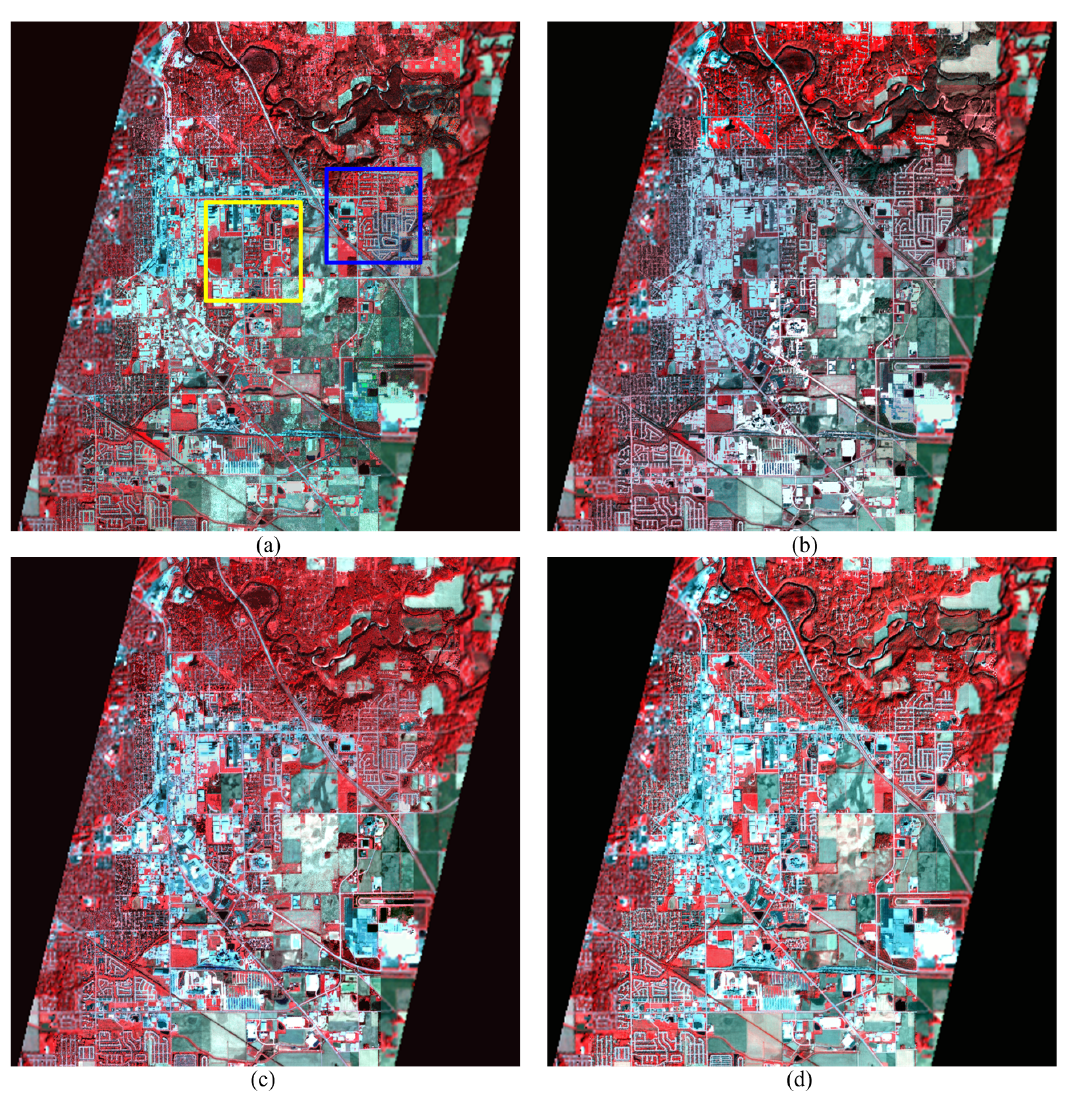
Figure 10. False color composite (bands 45, 21, 14) of different Hyperion-Sentinel fusion results, size of the enhanced image is 1023 × 1095 with 10 m resolution, ( a ) result of SSR [12]; ( b ) result of BayesSR [13]; ( c ) result of CNMF [6]; ( d ) result of Two-CNN-Fu. Table 5. The no-reference quality assessment scores of different results on Hyperion-Sentinel fusion.